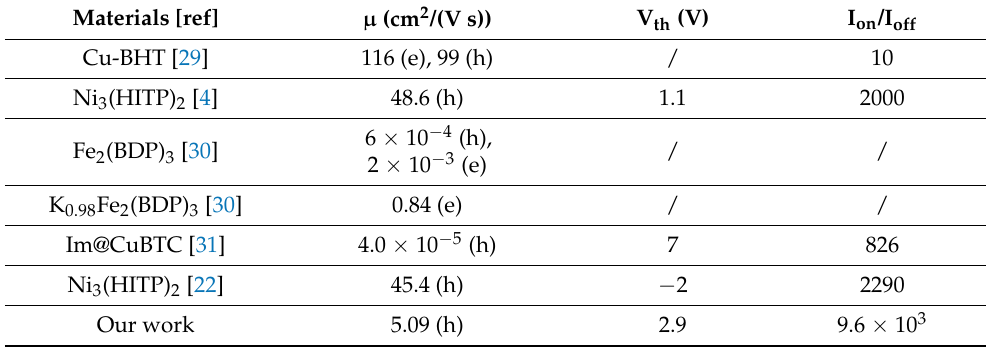
Table 2. Summary of conductive MOFs and their FET devices performance reported to